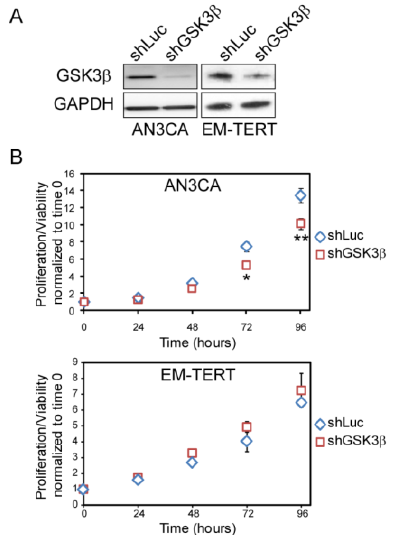
Figure 5. GSK3β knock-down by lentiviral shRNA showed similar effect on cell growth as compared to treatment with GSK3β inhibitors. Two shGSK3β knockdowns yielded similar results and data from shGSK3β-1 were shown. ( A ) Western blot of GSK3β demonstrating effective knock-down in AN3CA and EM-TERT cells by lentiviral infection; ( B ) MTT assay revealed that GSK3β knock-down inhibited AN3CA endometrial cancer cell growth, but had no effect on control EM-TERT cell growth. * p < 0.05; ** p < 0.01 compared to the control by Student’s t